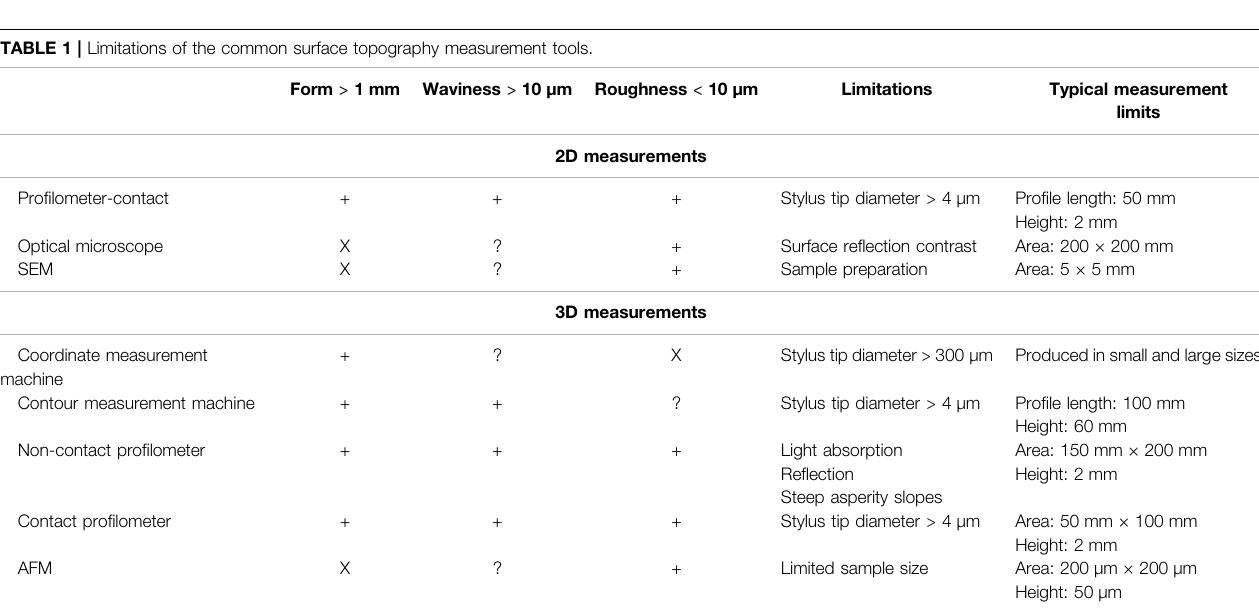
TABLE 1 | Limitations of the common surface topography measurement tools.